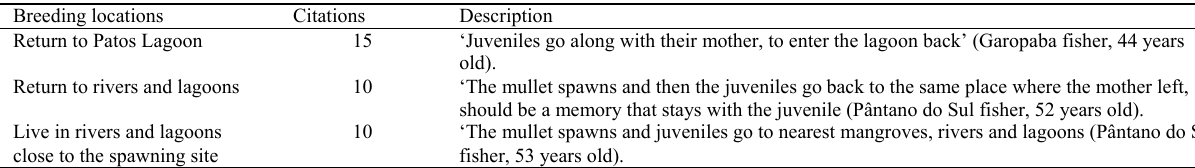
Table 5. Places where the juveniles live after spawning, according to 45 interviewed fishers in Santa Catarina State, Brazil (ten of our informants did not knew about this particular ecological